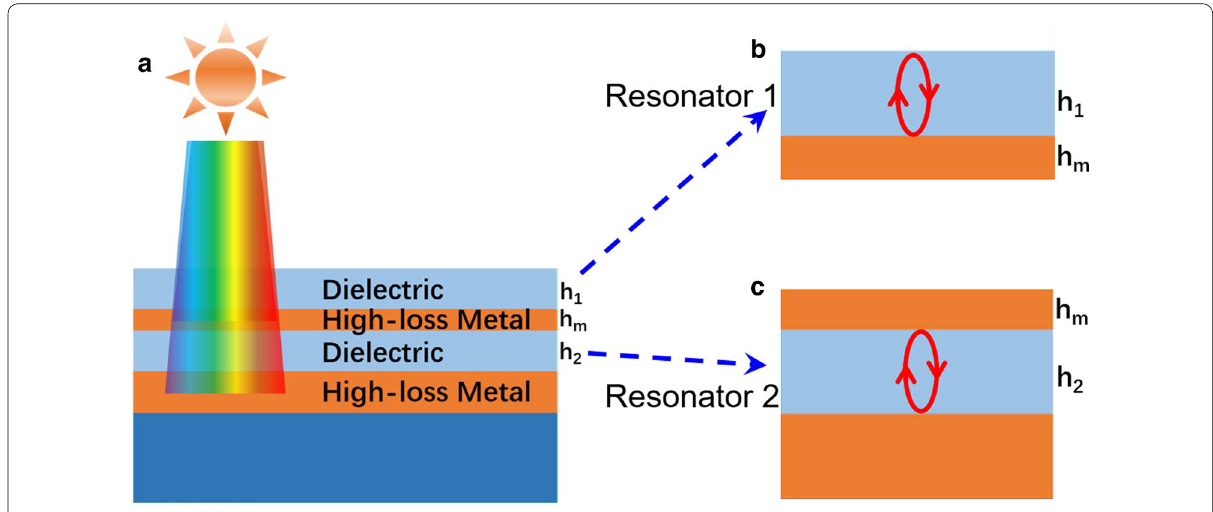
Fig. 1 Design of 1D few-layer